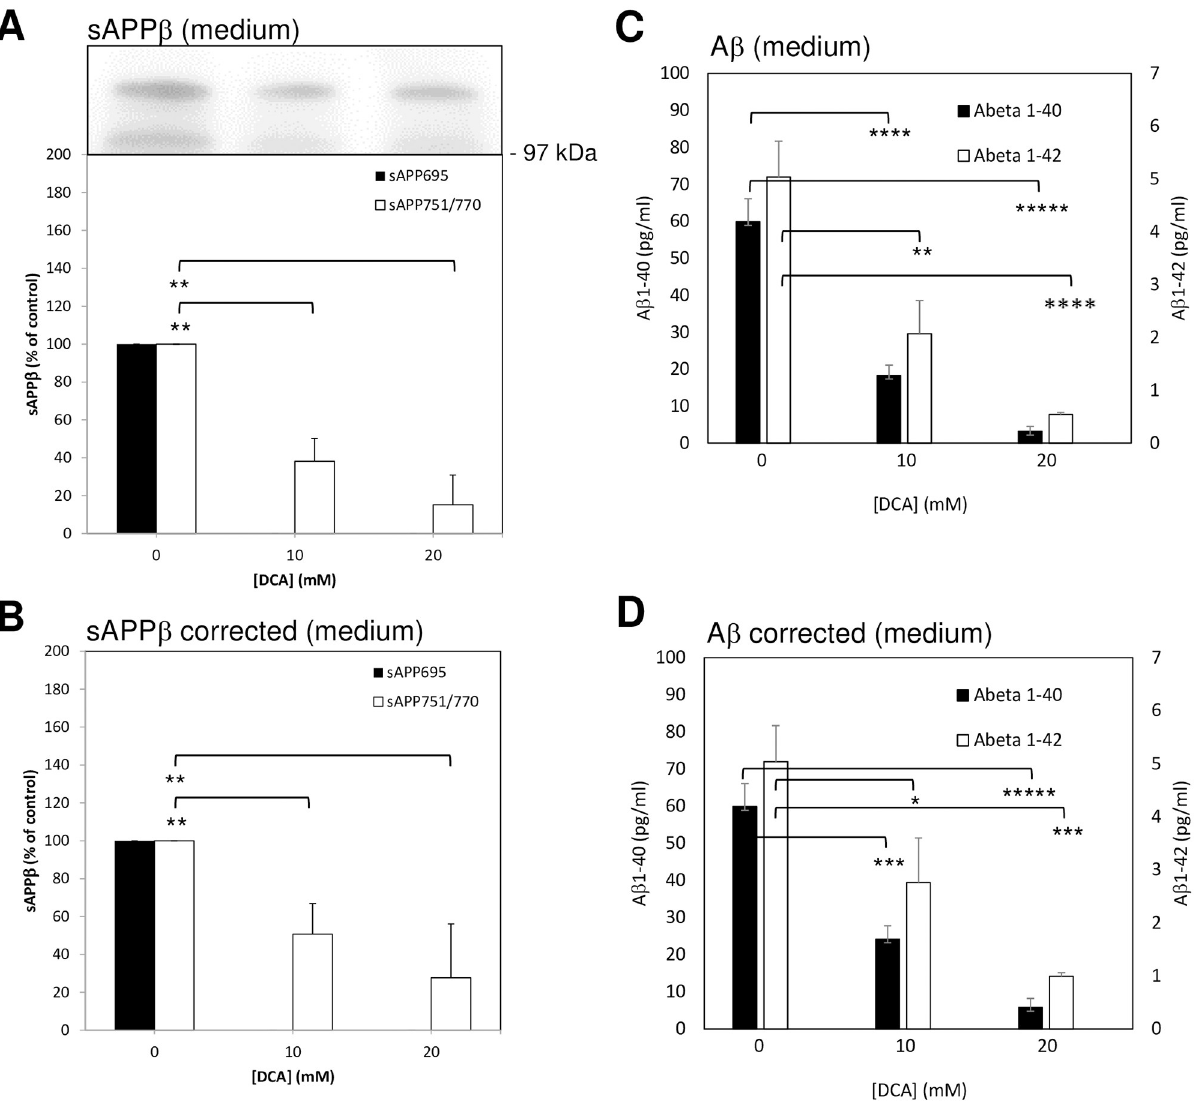
Fig 2. Growth of untransfected SH-SY5Y cells in the presence of DCA inhibits amyloidogenic APP processing. Cells were seeded and cultured in the presence of the indicated DCA concentrations and grown until the control cultures reached confluence (medium and DCA were replaced every two days). At this point the growth medium was replaced with UltraMEM containing the same DCA concentrations and the cells were cultured for an additional 24 h. Conditioned medium samples were either used unconcentrated (A β -peptide analysis) or concentrated before subjecting equal volumes to SDS-PAGE and immunoblotting (Materials and methods). (A) Conditioned medium samples were immunoblotted with anti-sAPP β antibody and multiple immunoblots were quantified and results expressed relative to control values without correcting for cell number. (B) The results in (A) were corrected to account for relative changes in cell number using data from the trypan blue assays in Fig 1A. (C) and (D) A β -peptide quantification in conditioned medium before (C) and after (D) correcting for changes in cell number. The sAPP β results are expressed relative to control (0 mM DCA) values whereas the A β -peptide results are absolute values (pg/mL). All results are means ± S.D. (n = 3). � = significant at p < 0.05; �� = significant at p < 0.01; ��� = significant at p < 0.005; ���� = significant at p < 0.001; ����� = significant at p <